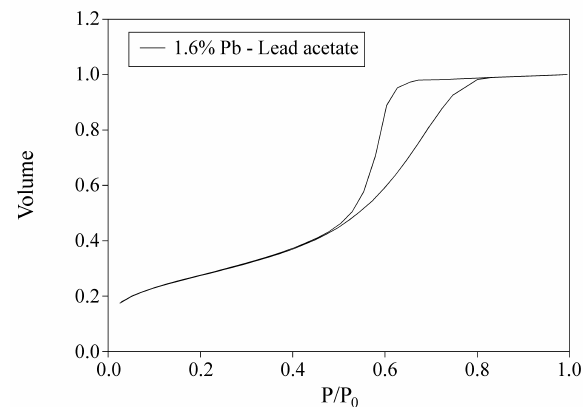
Figure 3. Sorption-desorption isotherm of gel obtained via lead acetate, heat treated at 105 °C (the weight of the sample was not considered, then volume scale is relative).